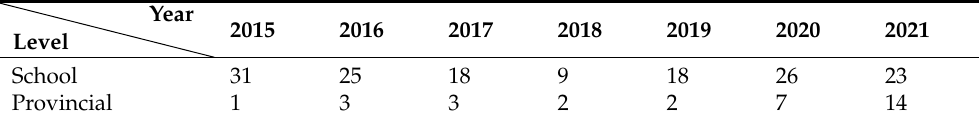
Table 6. S University’s BL projects.